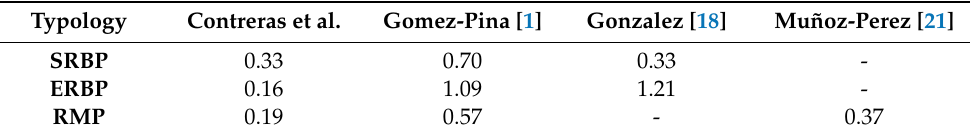
Table 3. MSE (dimensionless), calculated for the di ff erent authors and for each profile type. Typology Contreras et al. Gomez-Pina [1] Gonzalez [18] Muñoz-Perez [21] SRBP 0.33 0.70 0.33 - ERBP 0.16 1.09 RMP 0.19 0.57